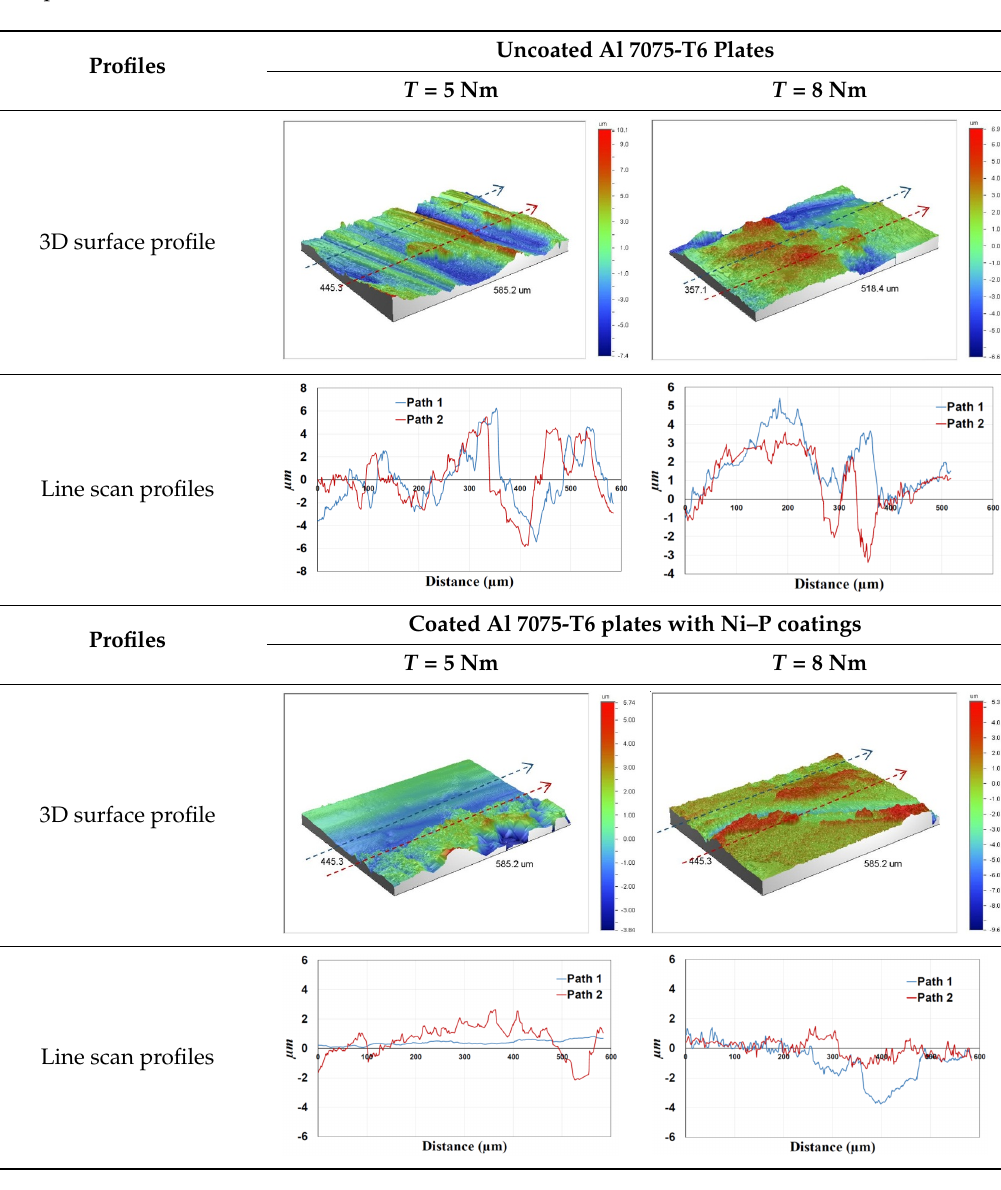
Figure 5. Average roughness R a for uncoated and coated aluminum plates clamped with 5 Nm and 8 Nm that failed under: ( a ) S max = 220 MPa, and ( b ) S max = 80 MPa. Table 1. 3D surface profile together with line scan profile for uncoated and coated aluminum plates clamped with 5 Nm and 8 Nm that failed under maximum remote stress of S max = 220 MPa.